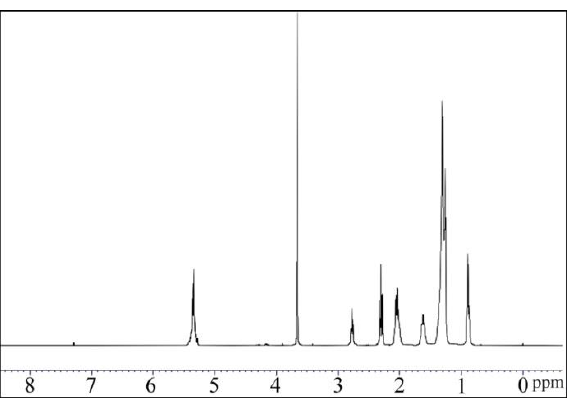
Figure 1. Typical 1 H NMR spectrum of fatty acid methyl